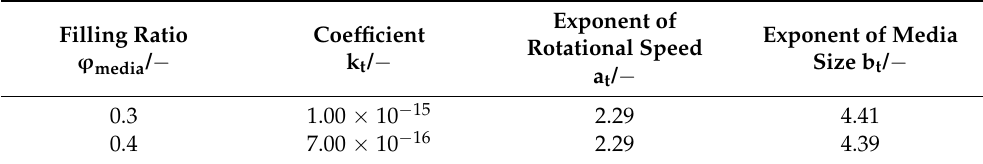
Table 8. Variables for model equation (Equation (15)) to describe the total stressing energy based on rotational speed n (in min − 1 ) and media size d media (in